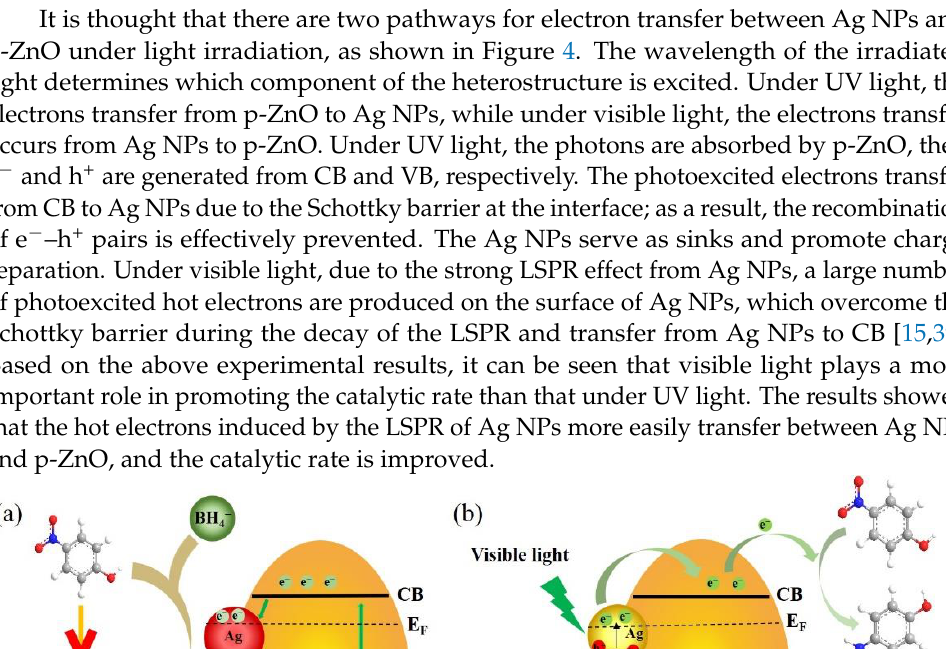
Figure 3. Plots of Ln(C t /C 0 ) versus the reaction time for the reduction of 4-NP over Ag/p-ZnO in the dark, and under UV and visible light irradiation.